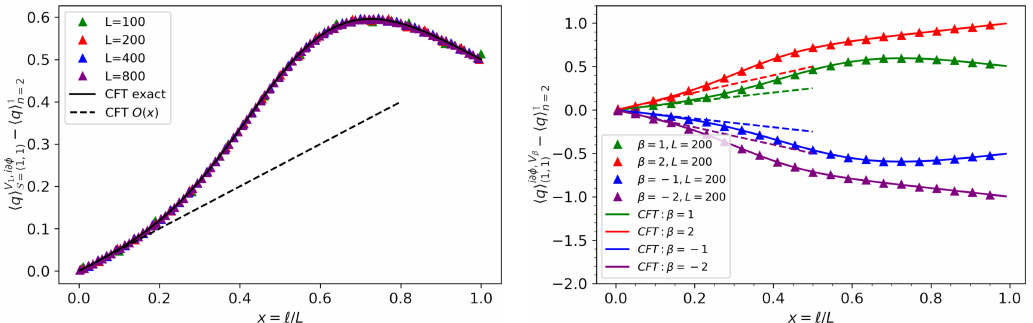
as a function of x is Figure 6 . Left: the CFT prediction of the excess of average h q i V 1 ,i∂φ − h q i 1 2 (1 , 1) plotted against the numerical data for the XX chain at different system sizes ( L = 100 , 200 , 400 , 800 ). The numerics match very well with CFT predictions even for relatively small system sizes (such as L = 100 ). Right: h q i V β ,i∂φ is plotted for different β ( β = − 2 , − 1 , 1 , 2 ) as a function of − h q i 1 2 (1 , 1) x = ‘/L . Numerical data refer to the low energy excitations of the half-filled XX chain for L = 200 . The O ( x ) predictions from OPE calculation (dashed lines) are clearly working well only for small values of x , up to x ∼ 0 . 2